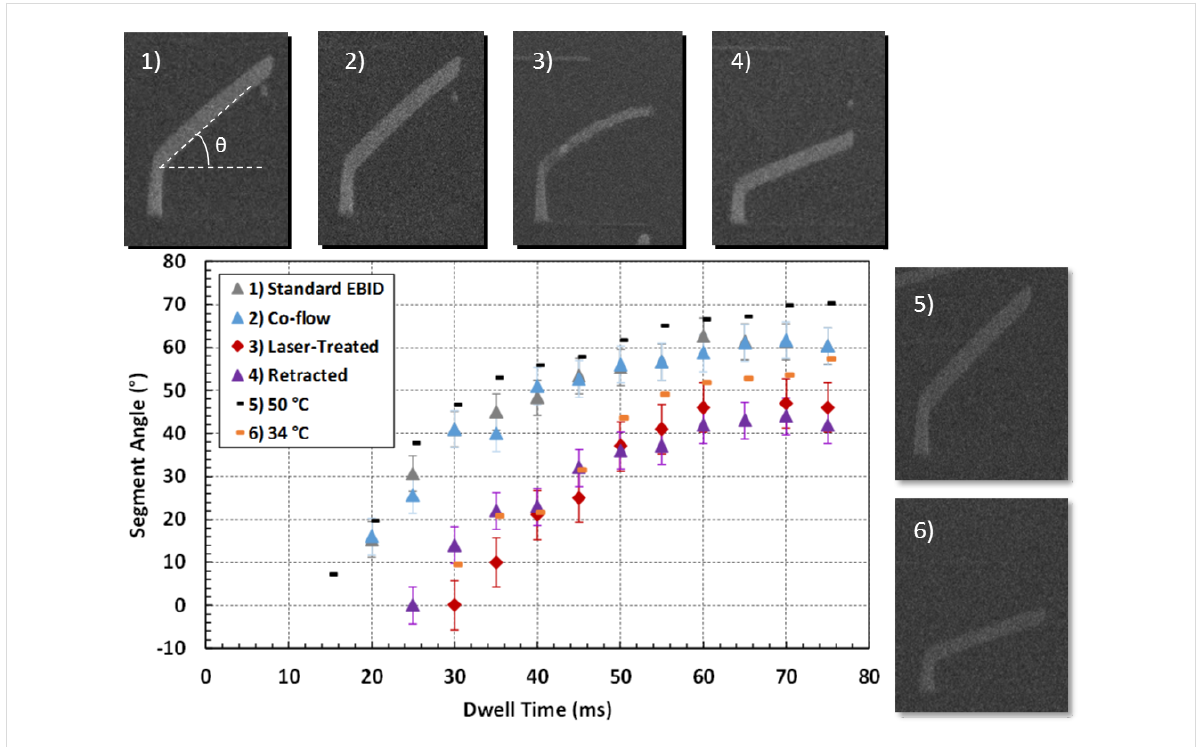
Figure 2: Segment angle plotted as a function of dwell time per pixel grown under six different conditions: 1) EBID with standard precursor tempera- ture at 45 °C and a resultant chamber pressure of 1.2 × 10 − 5 mbar (gray). 2) EBID standard Pt precursor conditions with an argon-oxygen co-flow at 1.83 × 10 − 5 mbar (blue). 3) EBID with standard Pt precursor conditions with laser irradiation at a pulse width and frequency of 10 µs and 100 Hz, re- spectively (red). 4) EBID with standard Pt precursor conditions with a retracted nozzle and lower precursor flux (purple). 5) and 6) EBID with the pre- cursor temperature raised or lowered, respectively, as indicated (black and orange). SEM images of the resulting pillar and segment, for each growth condition, are provided, where a common dwell time of 40 ms was used for each EBID condition. The SEM images were acquired at a tilt angle of 52° with respect to the plane containing the pillar and segment. For scale, the projection of each cantilever arm is 400